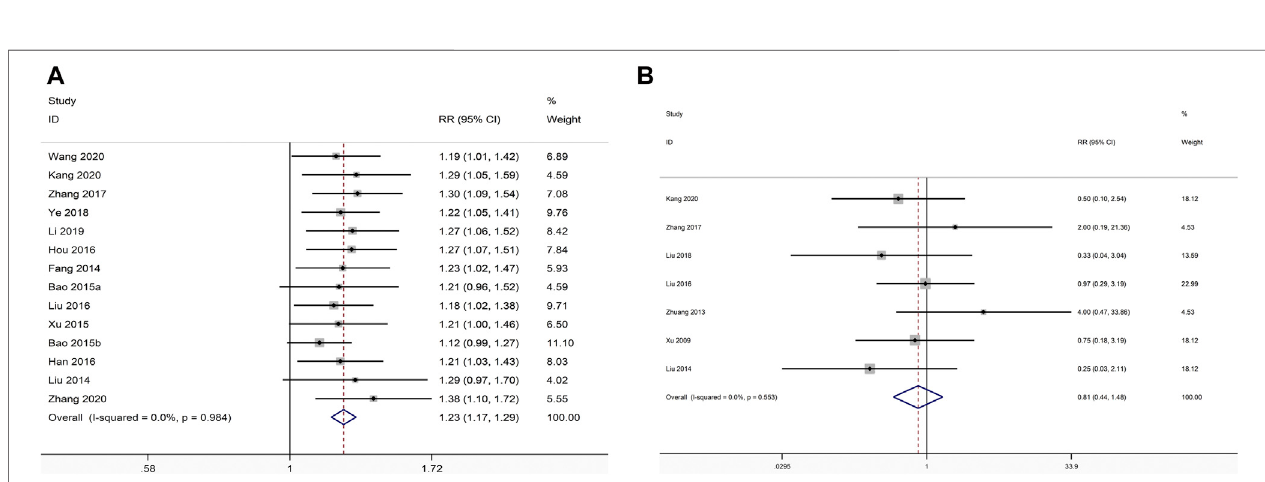
FIGURE 7 | Forest plot of XLGB combined with ALE vs. ALE alone with regard to effective rate (A) and ADR (B) .